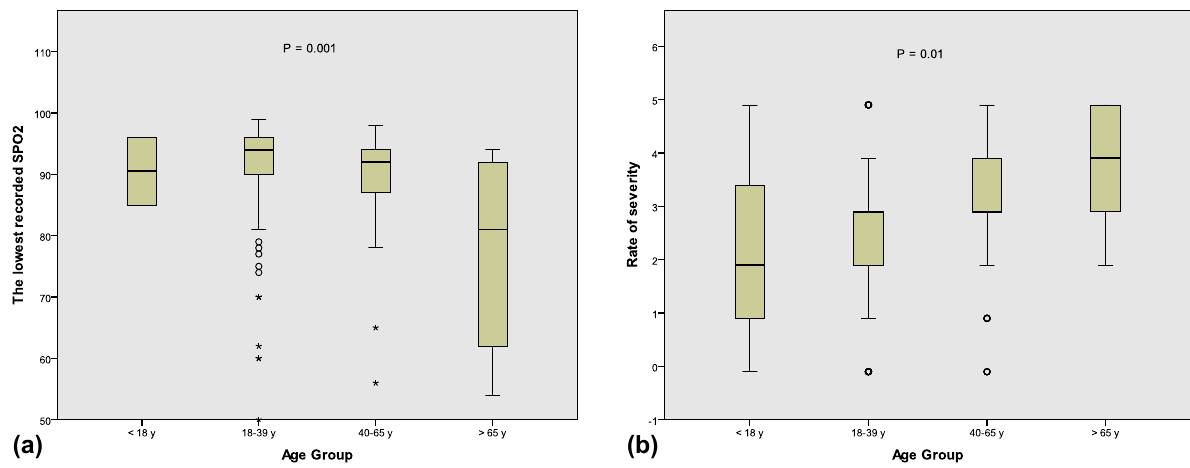
Figure 2: Comparison of severity rating ( a ) and lowest recorded SpO 2 ( b ) between the di ff erent age groups.